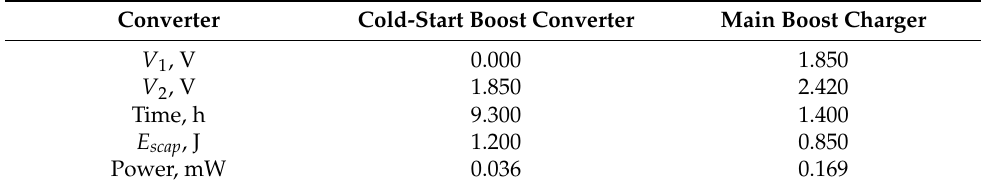
Table 4. Values of energy stored in each transmission period of the sensor node.